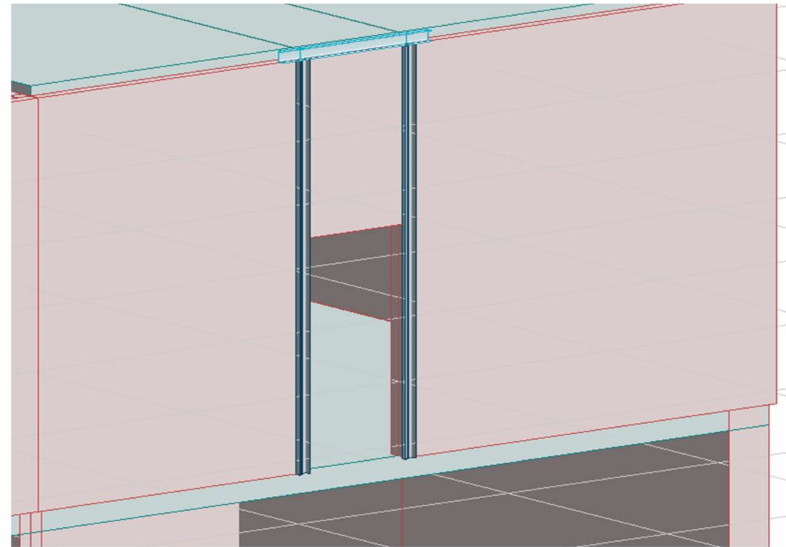
Figure 22. Modeled PSS (U2).